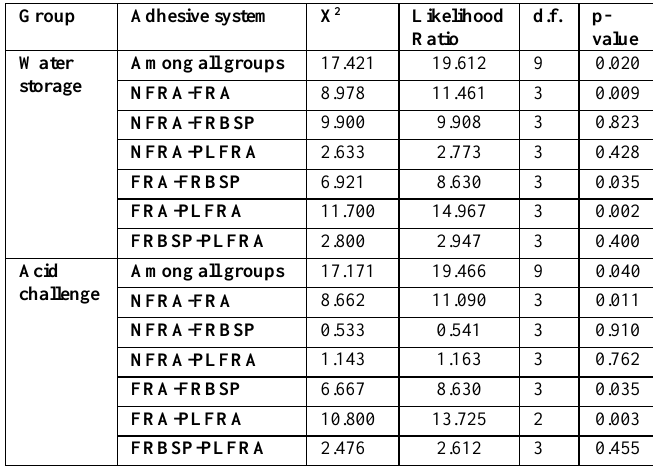
Table 1: Descriptive statistics of the shear bond strength test of different